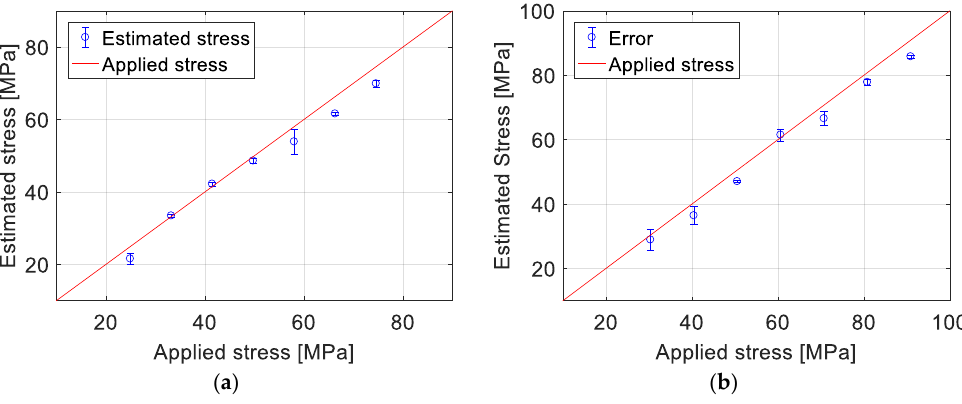
Figure 13. Experimental set-up for the proposed stress estimation.